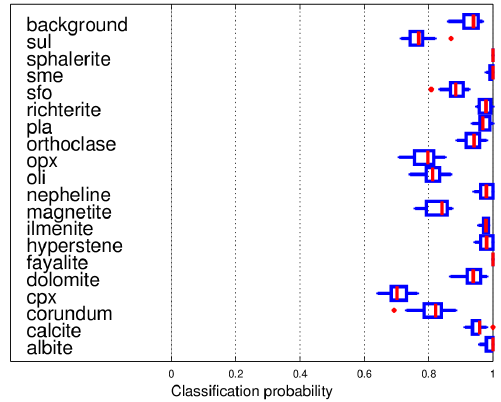
Figure 7. Cross validation accuracies showing the Cohen κ value computed for the data projected to a 100 dimensional space using random projections. For this case, a separate reference background measurement is made. When included the Cohen κ ∼ 0.88 ±